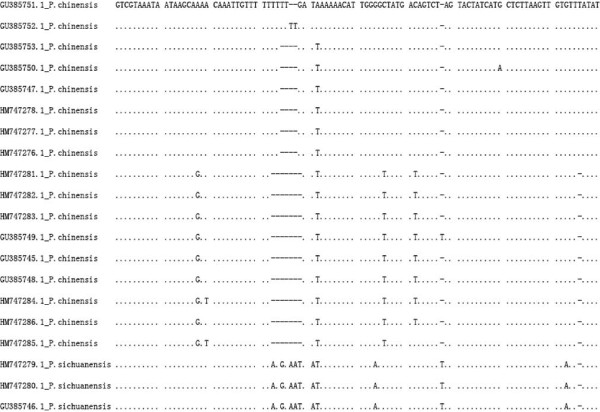
The ITS2 sequence alignment of P. chinensis and P. sichuanensis. Presented partial sequences show the variations. There are three major types of variants.